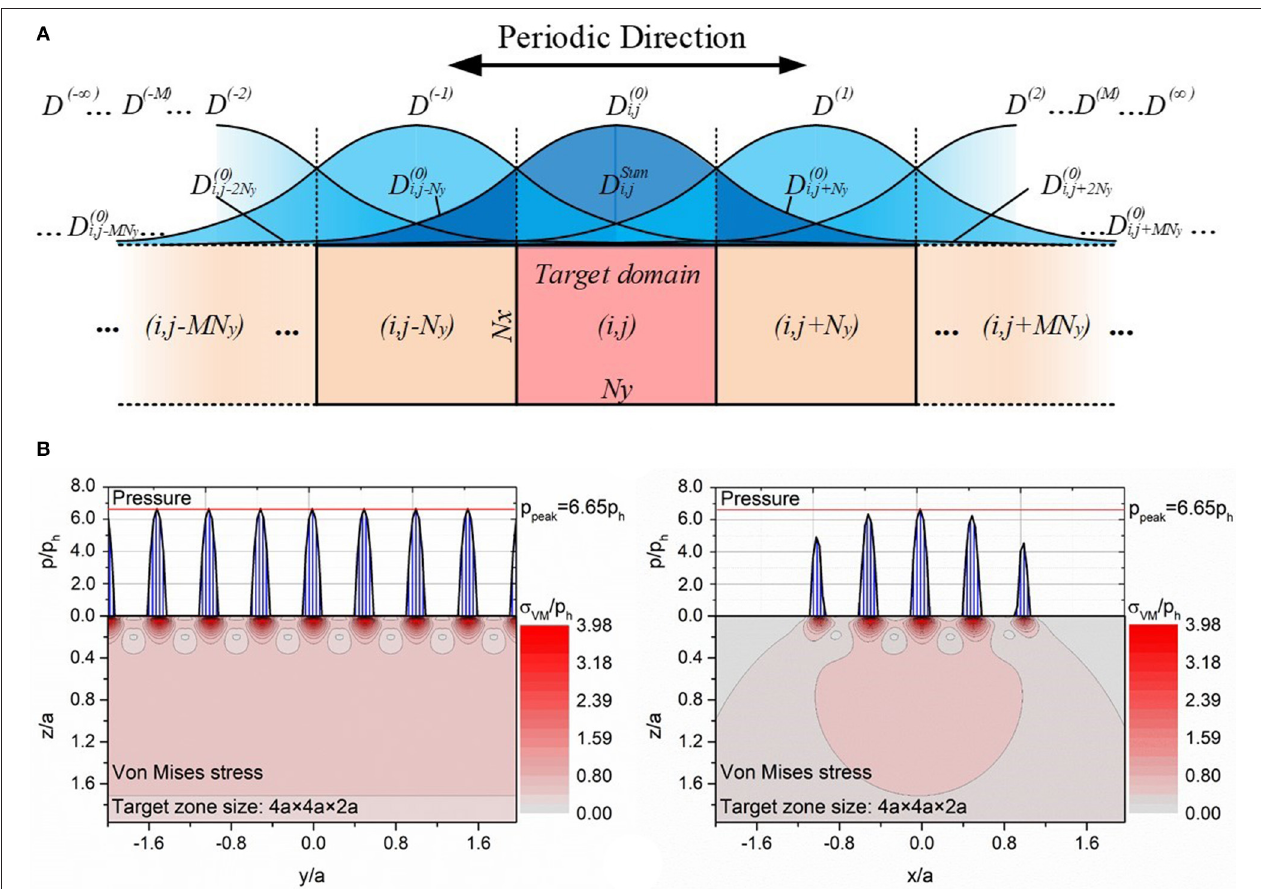
FIGURE 6 | IC summation in the periodic convolution (A) and 3D line contact of a smooth, rigid cylinder, and a flat rough surface calculated by using the DCS-FFT algorithm (B) .